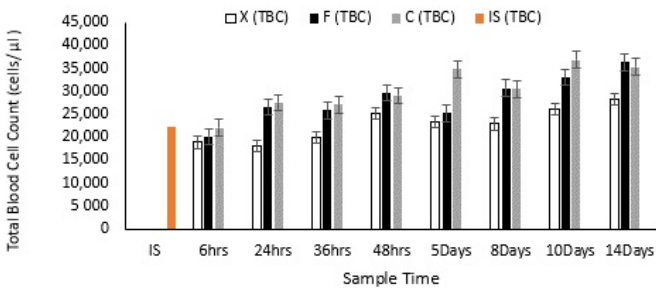
Figure 8. Total blood cell ( TBC ) count for the control and treated oysters, with the mean TBC for the Initial sample group ( IS ) also shown .